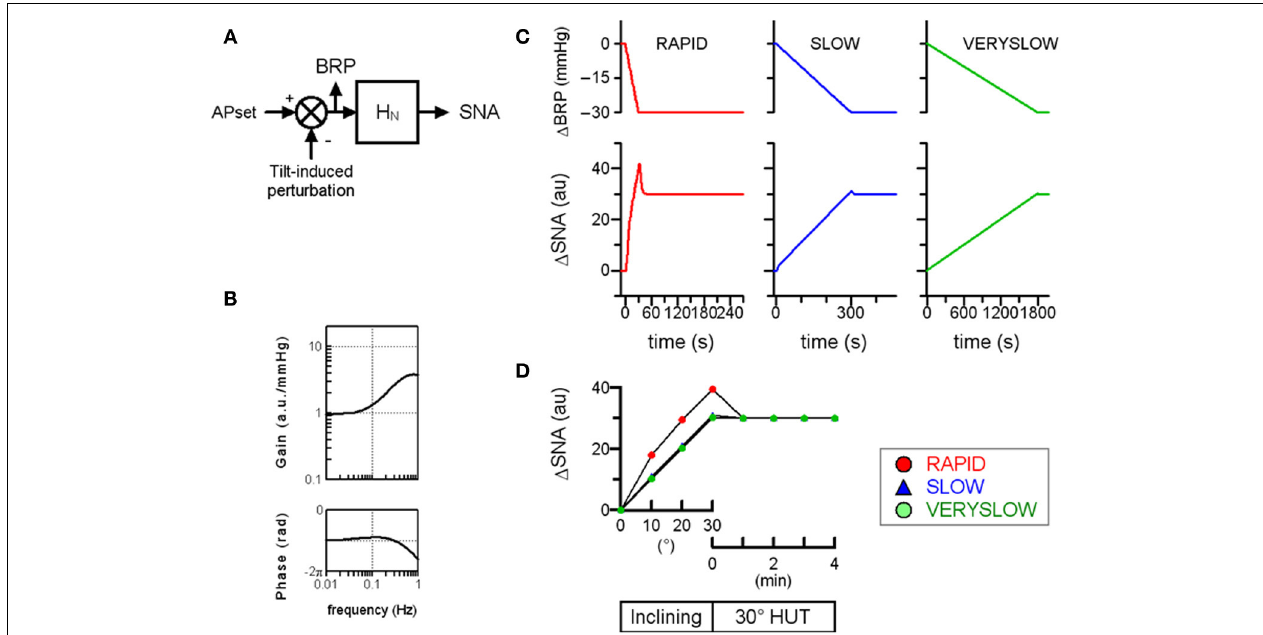
FIGURE 2 | Simulation of orthostatic activation of SNA in response to HUT at different inclining speeds in the baroreflex open-loop condition. (A) A block diagram of baroreflex control of SNA containing the neural arc transfer function ( H N ). We assigned maximum tilt-induced perturbation of − 30mmHg in the simulations, equivalent to − 1, − 0 . 1, and − 0 . 0167mmHg/s in RAPID, SLOW and VERYSLOW HUT tests, respectively. We set APset at 100mmHg. BRP; baroreceptor pressure. (B) The gain and phase function of H N . The gains K N are set at 1au/mmHg. The fc 1 , fc 2 , and L are set at 0.1, 0.8, and 0.2, respectively, based on animal experimental data.